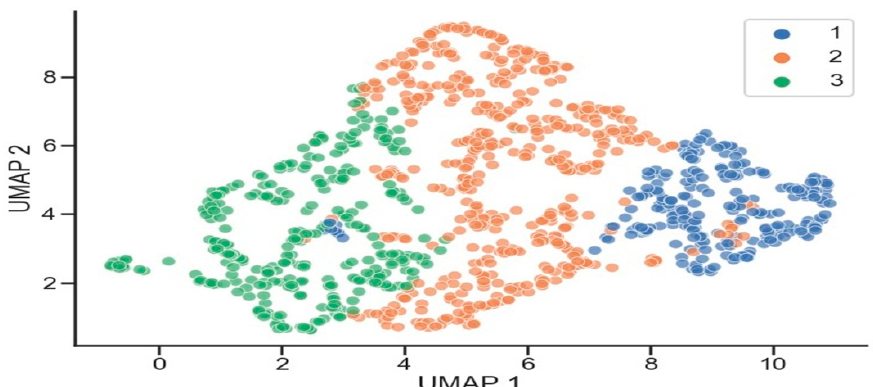
Figure 2. Uniform Manifold Approximation and Projection (UMAP) representation of the three clusters of patients. Three clusters of patients: blue, light brown, and green represent mild, moderate, and severe bronchiectasis patients, respectively.